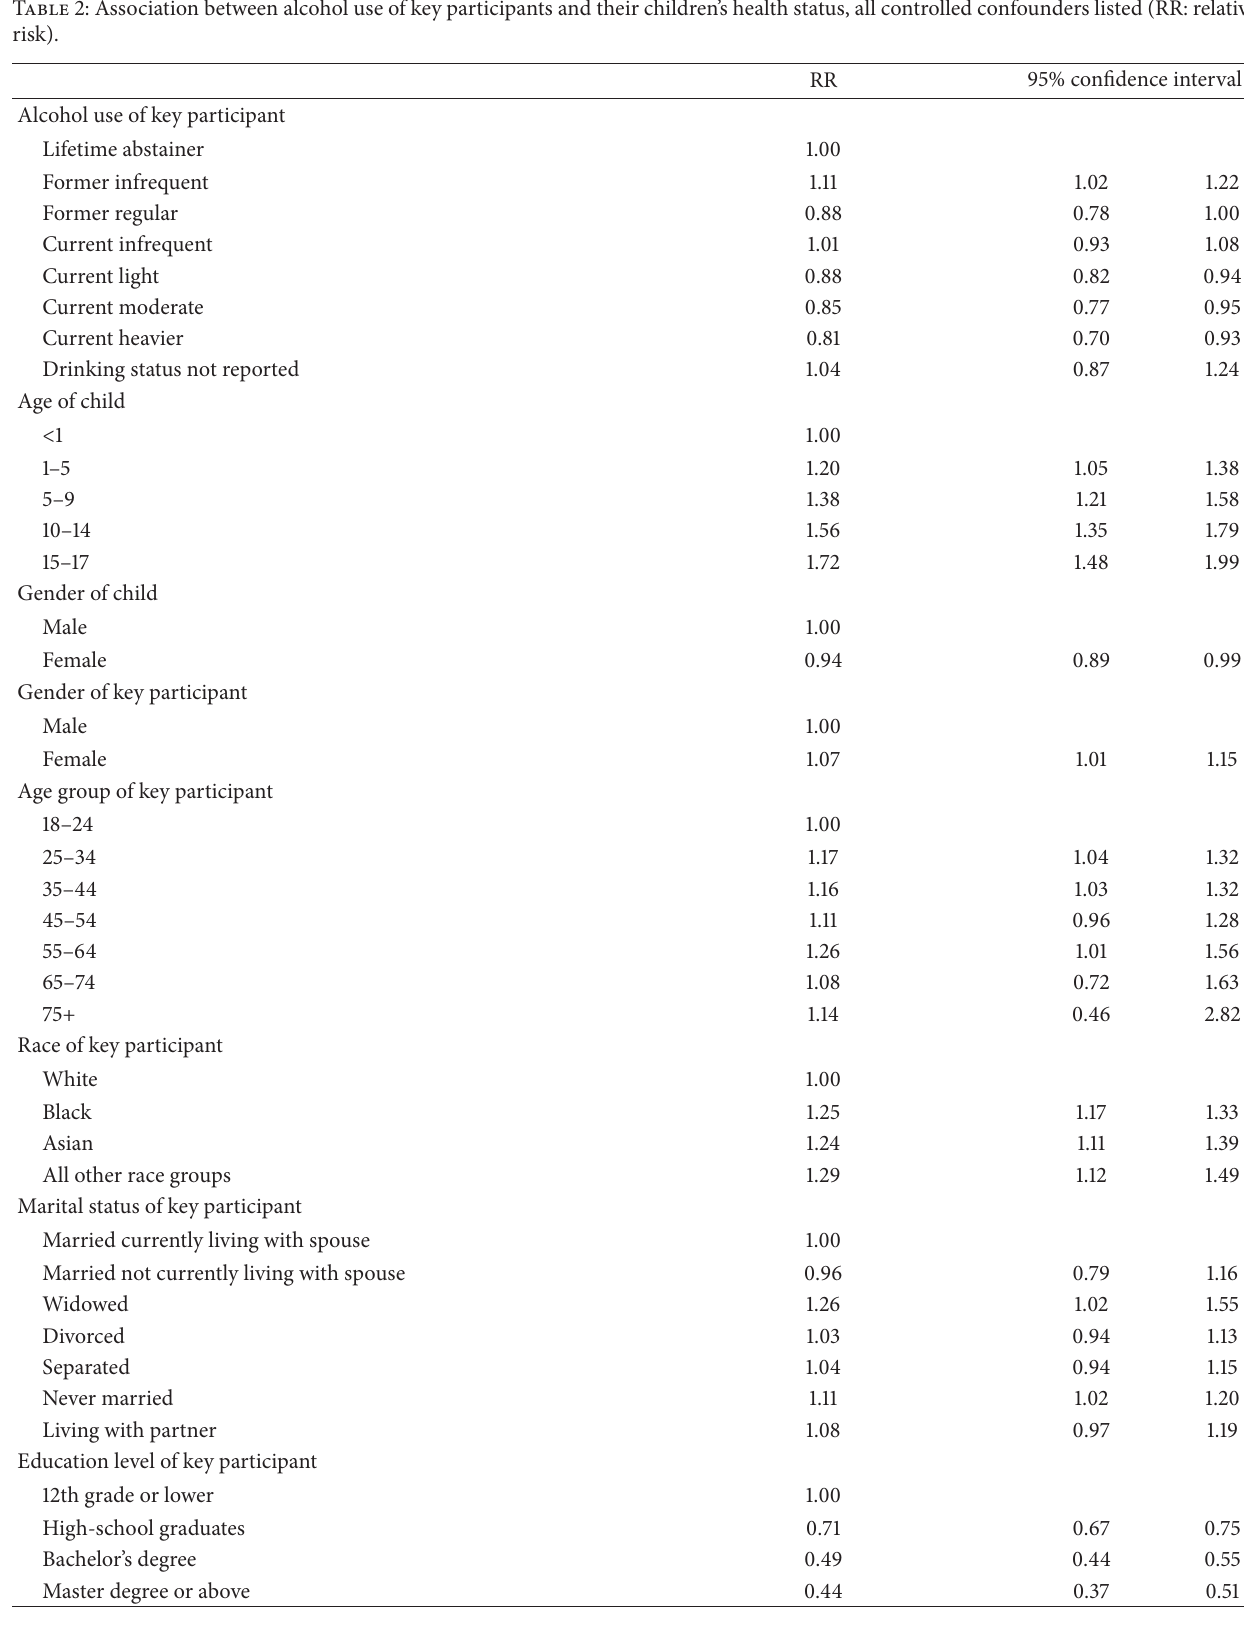
Table 2: Association between alcohol use of key participants and their children’s health status, all controlled confounders listed (RR: relative